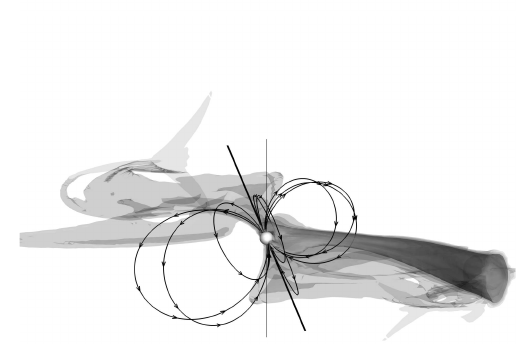
Figure 2: The same as in Fig. 1 for the model 3 with B a = 10 6 G.